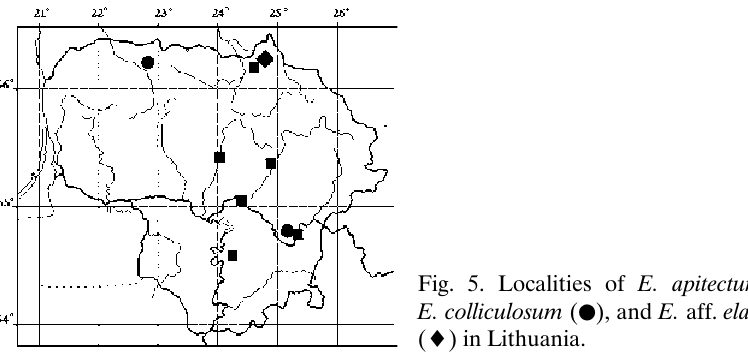
Fig. 5. Localities of E. apitectum (■), E. colliculosum (●), and E. aff. elachiston (♦) in